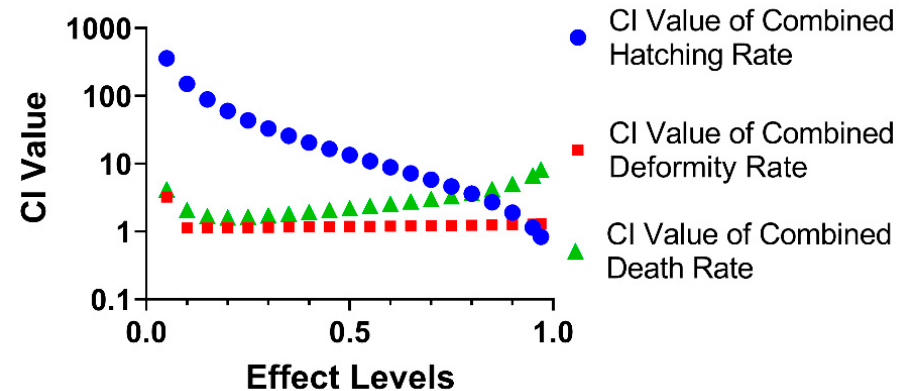
Figure 4. Combination indices (CI values) of MIX for 48 hpf hatching rate (blue), 96 hpf deformity rate (red), and 96 hpf death rate (green). The CI values indicate that ENF antagonized the toxic effects of CAR on hatching rate, especially at low effect levels, and on death rate at higher effect levels.